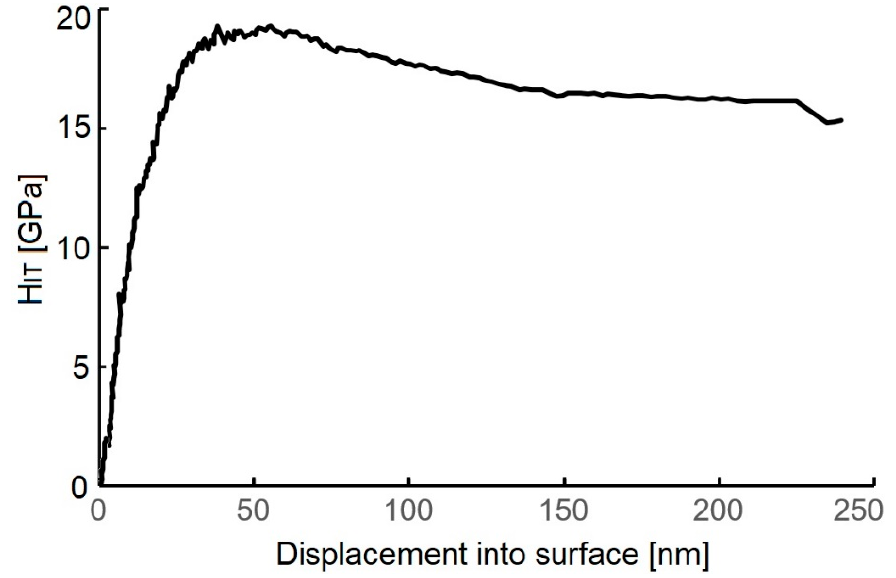
Figure 7. Depth profile of the H IT values of the tested WC/C coating.